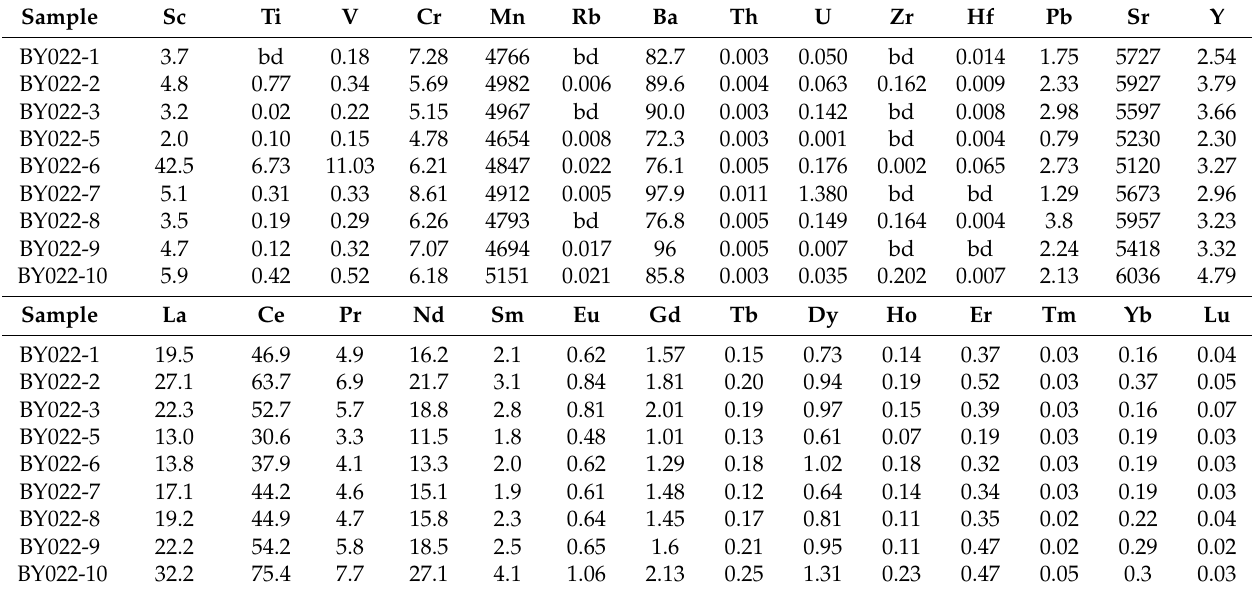
Table 2. Trace element concentrations (ppm) of dolomite minerals from the